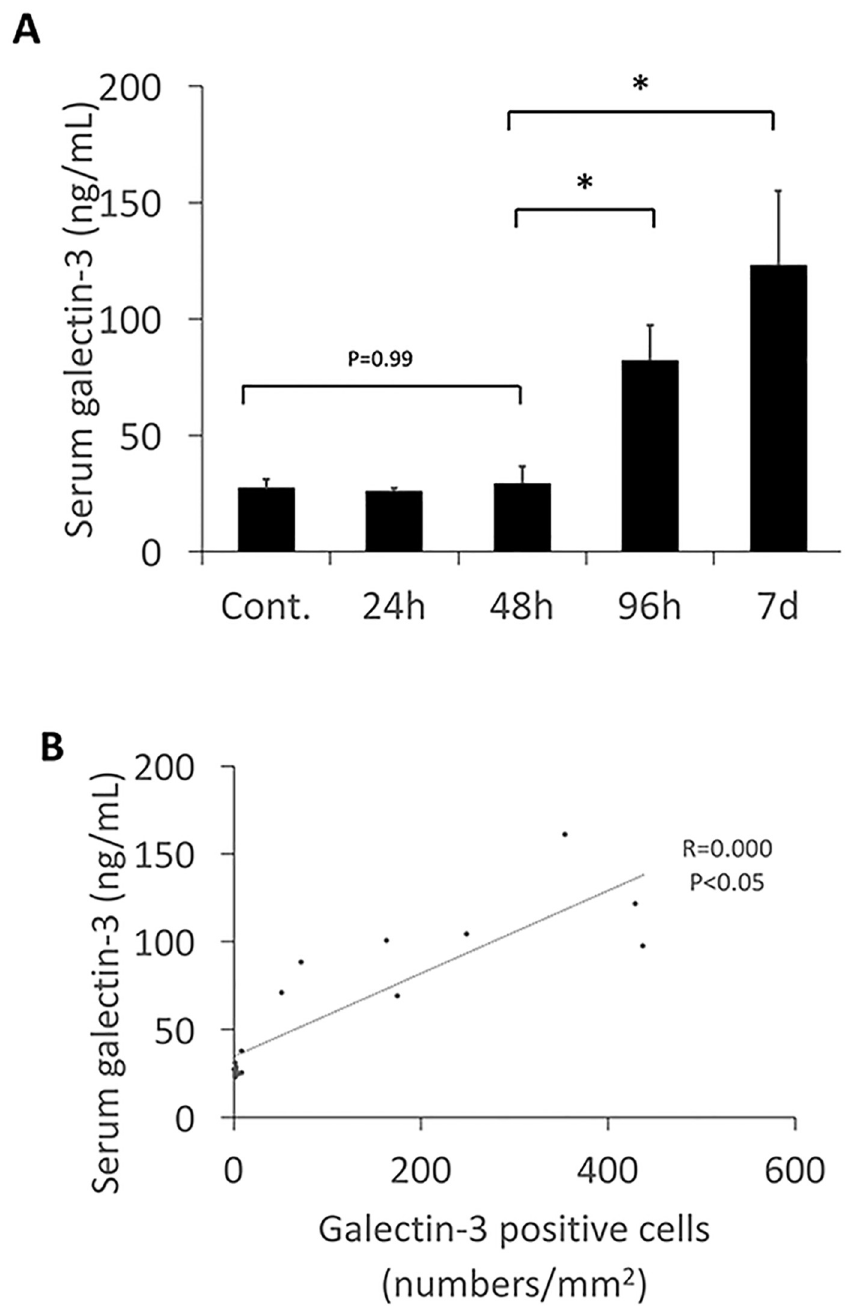
Fig 4. A, The serum level of galectin-3. Serum level of galectin-3 increased markedly 96 hours after virus inoculation, and continued to increase until 7 days. Data suggest there is an association between serum galectin-3 level and galectin-3 positive cell numbers or fibrosis in the cardiac tissues. � Statistically different from each group (p < 0.05), determined by ANOVA. B, Association between galectin-3 positive cell number and serum levels of galectin-3. The galectin-3 positive cell numbers were positively correlated with serum levels of galectin-3. � Statistically different from each group (p < 0.05), determined by ANOVA.